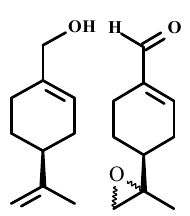
Figure 1. Chemical structures of ( S )-( − )-perillyl alcohol and perillaldehyde